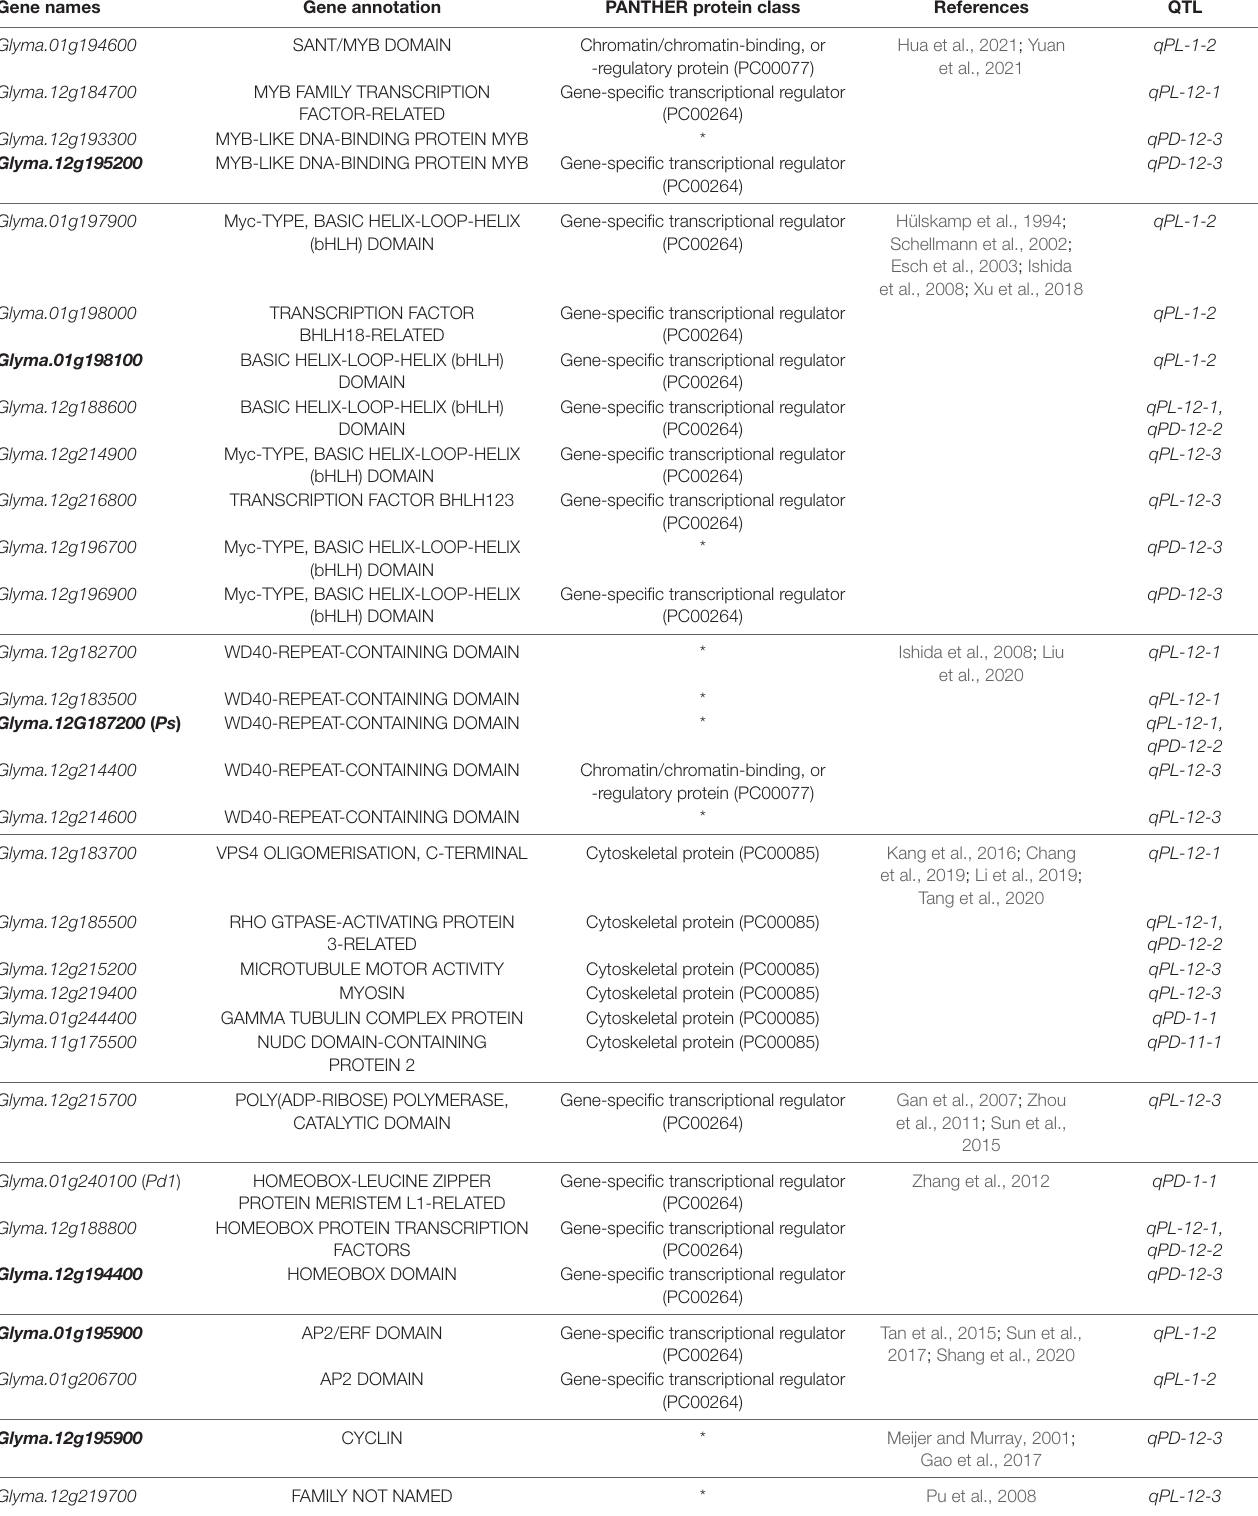
*Indicates these genes are selected based on gene annotation and literatures. The gene name in bold font represents the important candidate gene. QTL, quantitative trait loci; PANTHER, Protein Analysis THrough Evolutionary Relationships.